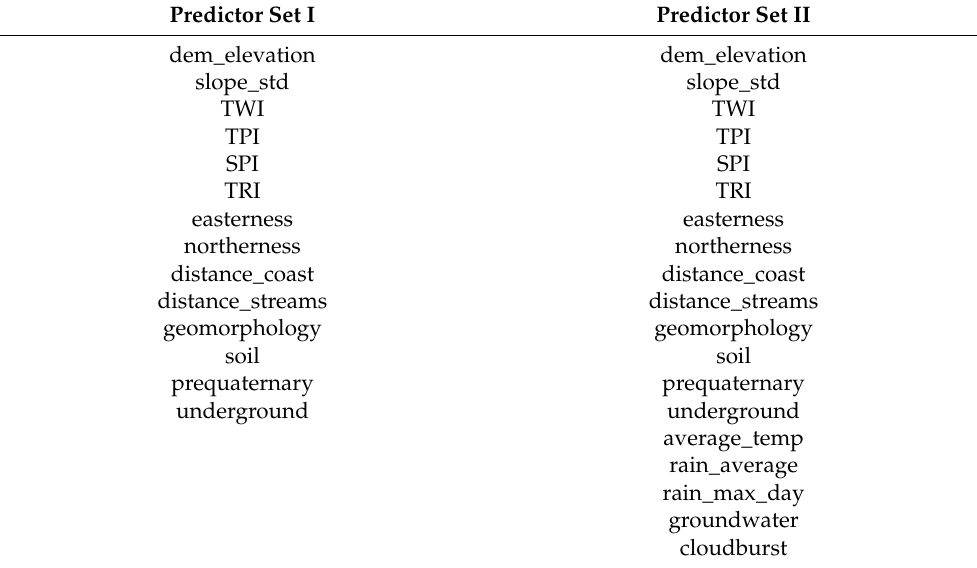
Table 4. Overview of the final selection of the variables for the two predictor